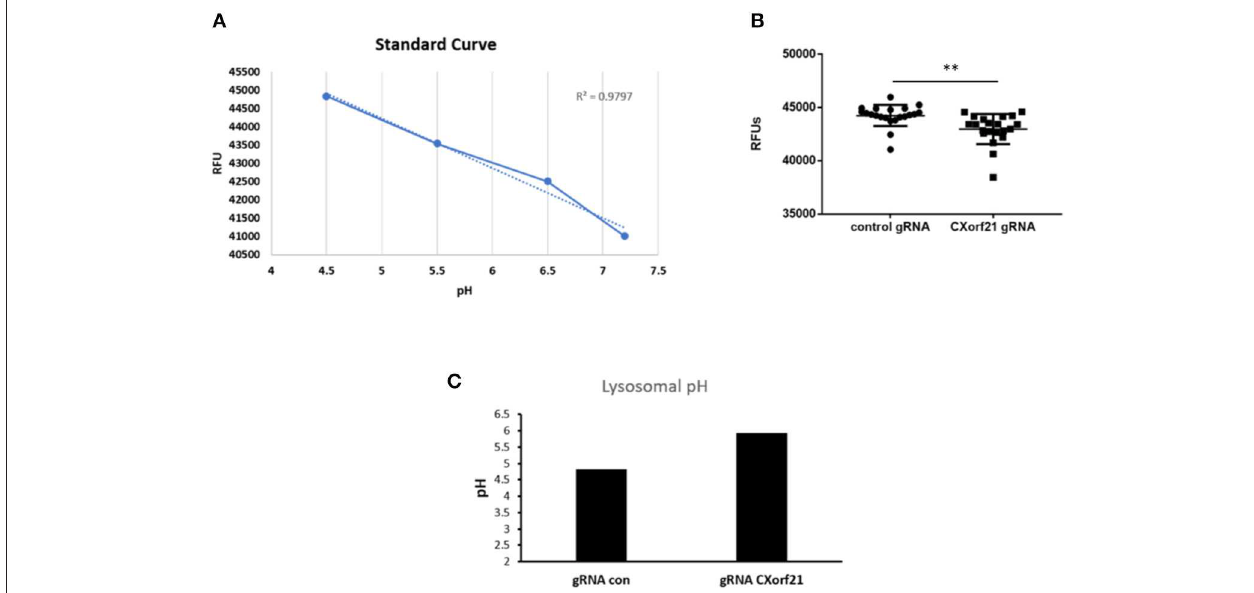
FIGURE 4 | Knockdown of CXorf21 increases lysosomal pH in 46,XX female monocytes. (A) Standard curve using pHrodo TM Red AM with Intracellular pH Calibration Buffer kit for the translation of fluorescence ratios in pH. An average of six data points was plotted in the graph and a linear trend line was fit to get a pH standard curve. Female monocytes transfected with control or CXorf21 gRNA were stained with pHrodo TM Red solution and (B) relative fluorescence units (RFUs) were measured with multi-well plate reader (details in section Materials and Methods). N = 8; error bars represent SEM; ** p = 0.001. (C) pH was determined based on RFUs using the standard curve.